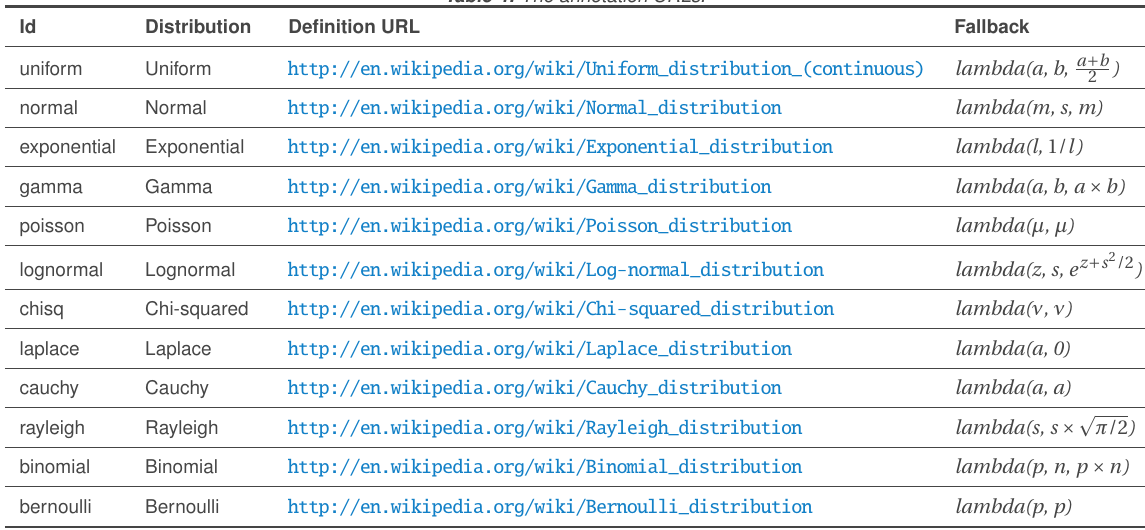
Table 4: The annotation